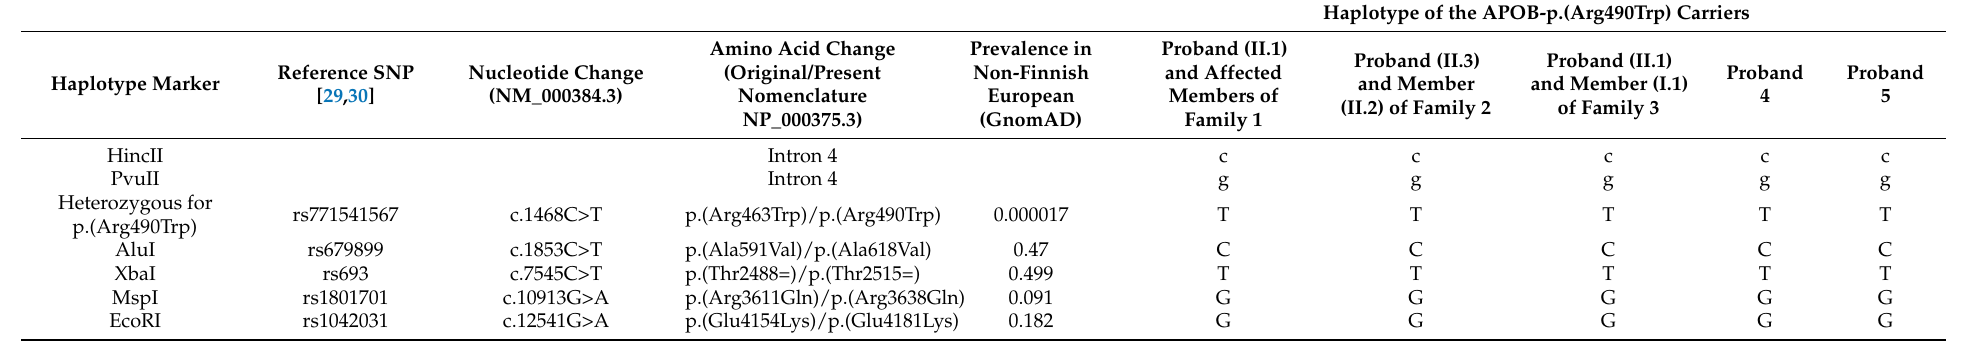
Table 2. Mutant haplotypes of the affected probands and relatives harboring the p.(Arg490Trp) (p.(Arg463Trp) according to the original nomenclature)